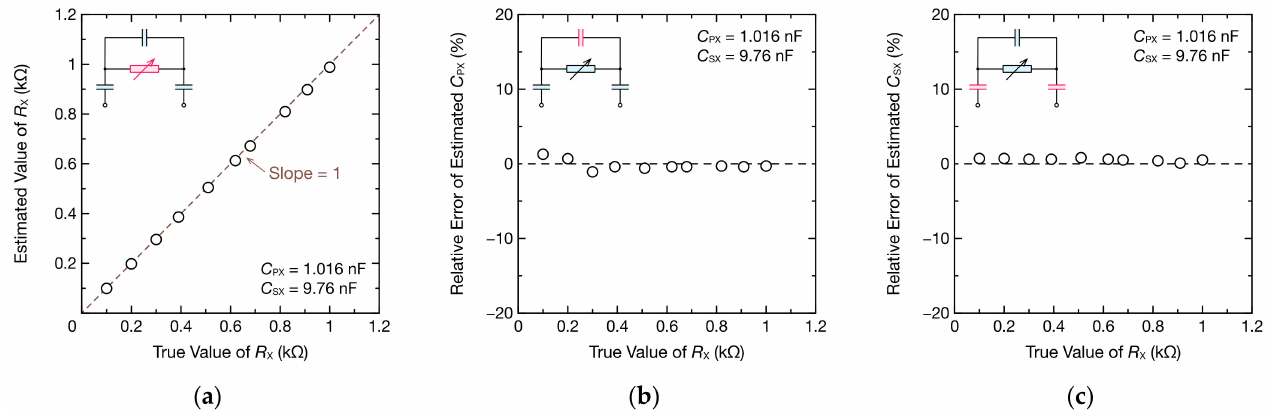
Figure 9. R X , C PX , and C SX of the parallel RC circuits estimated using oscillation waveforms and DFT: ( a ) the estimated R X , ( b ) relative error of the estimated C PX , and ( c ) relative error of the estimated C SX . The insets are the circuit model used for fitting, and the estimated parameters are highlighted in